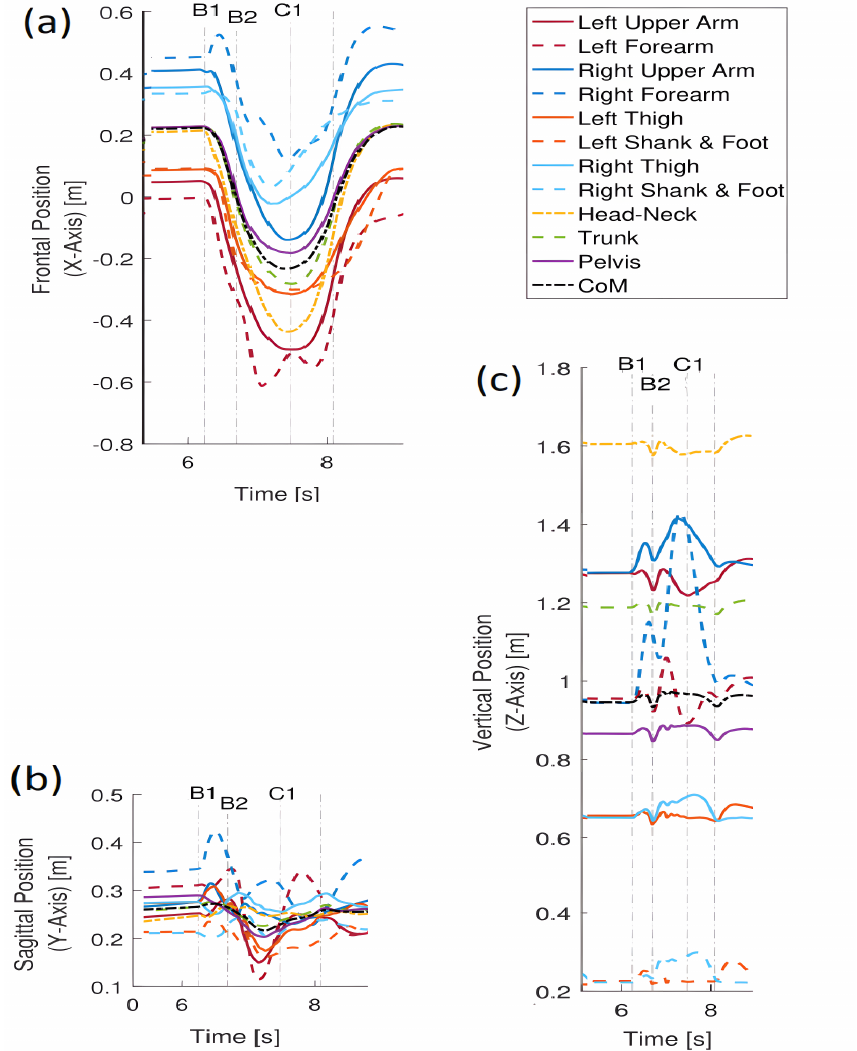
Figure 9. Displacement trajectories during push recovery with free arms. ( a ) trajectories along the X-axis; ( b ) trajectories along the Y-axis; ( c ) trajectories along the